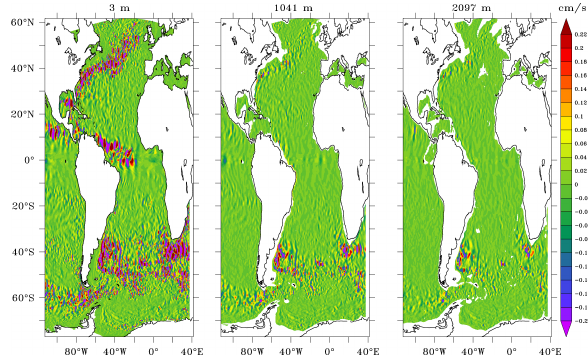
Figure 20: Different depth ranges of mesoscale features in the North and South Atlantic. Difference Fig. 20. Different depth ranges of mesoscale features in the North between A025 and B025 for meridional velocities. and South Atlantic. Difference between A025 and B025 for merid- ional